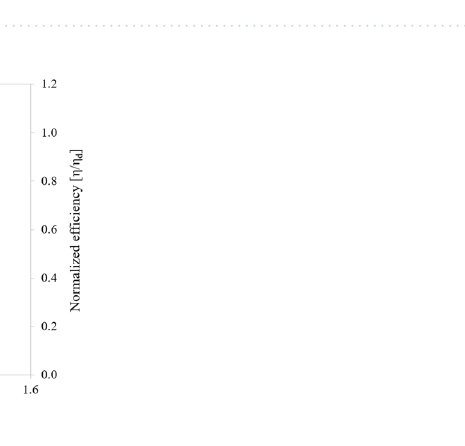
Figure 15. Blade loading distribution at different spans on the impeller at 5% pre-swirl intensity. ( a ) 0.6 ϕ d and ( b ) 0.85 ϕ d .